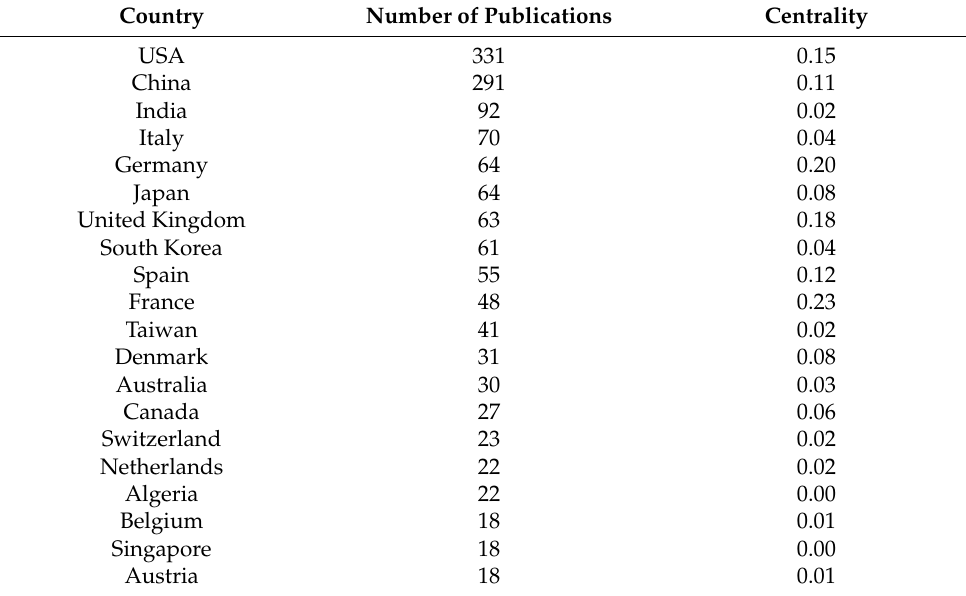
Table 1. The number of publications and